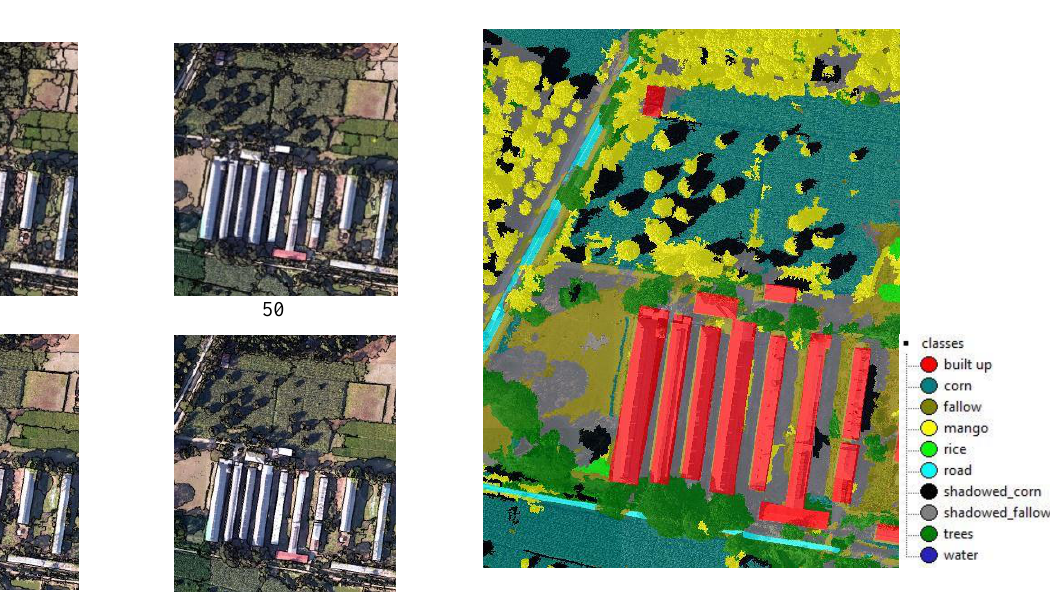
Figure 6. The result of 25 scale parameter